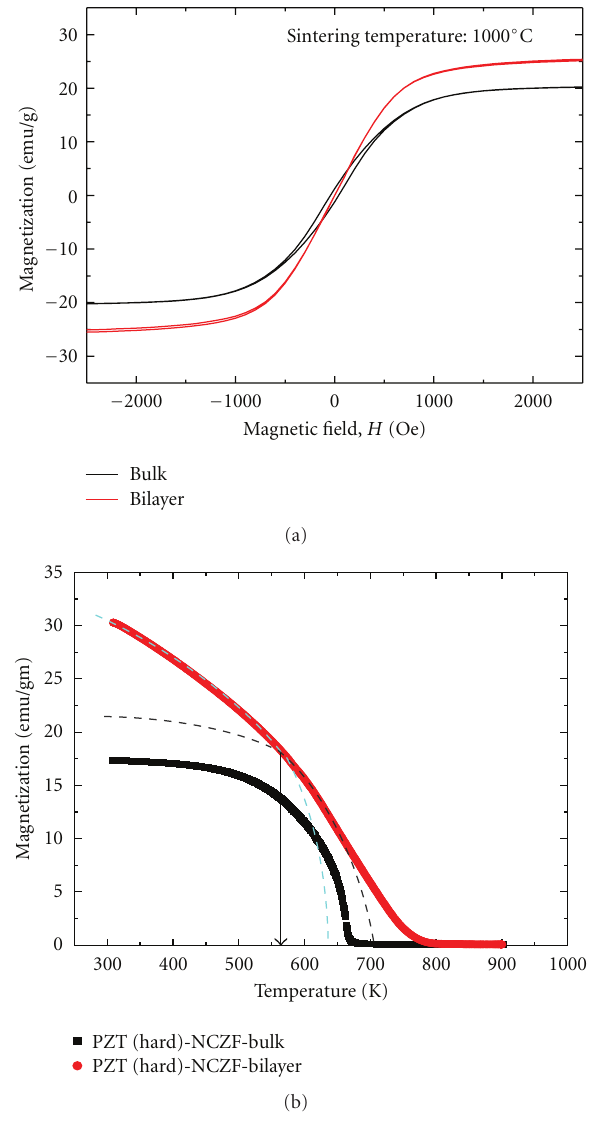
Figure 10: Ferromagnetic property of two types of composite. (a) Moment versus Field (hysteresis loop). (b) Magnetization as a function of temperature. Figure 11: Bright-field TEM image of PZT-5 NFM composite. (a) After sintering, (b) after annealing and